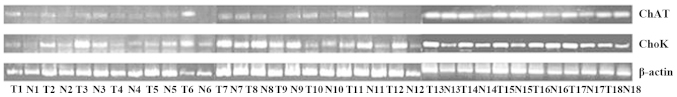
ChAT and ChoK mRNA expression in lung lesion biopsies. RT-PCR was performed to detect ChAT and ChoK mRNA expression on total RNA prepared from the lung lesion biopsies (T) and normal lung tissues (N). Primers used for RT-PCR are described in Table 1. β-actin mRNA was amplified and used for standardization. ChaT, choline acetyltransferase; ChoK choline kinase α; RT-PCR, reverse transcription polymerase chain reaction.